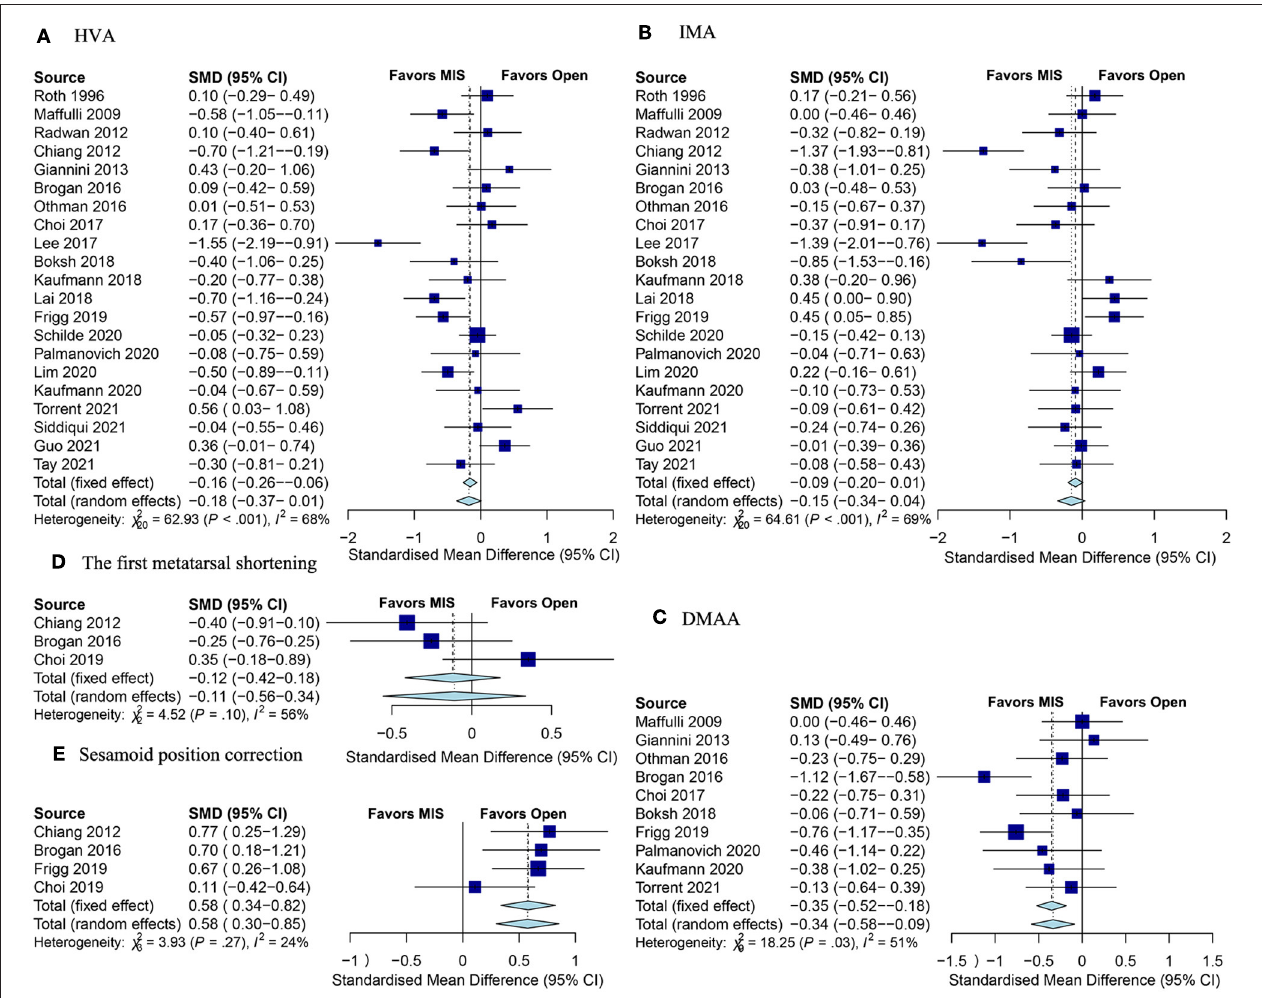
FIGURE 3 | Forest plots of radiologic outcomes. (A) HVA between the MIS and open groups; (B) IMA; (C) DMAA; (D) the first metatarsal shortening; and (E) the medial sesamoid position correction. HVA, hallux valgus angle; MIS, minimally invasive surgery; IMA, first intermetatarsal angle; DMAA, distal metatarsal articular